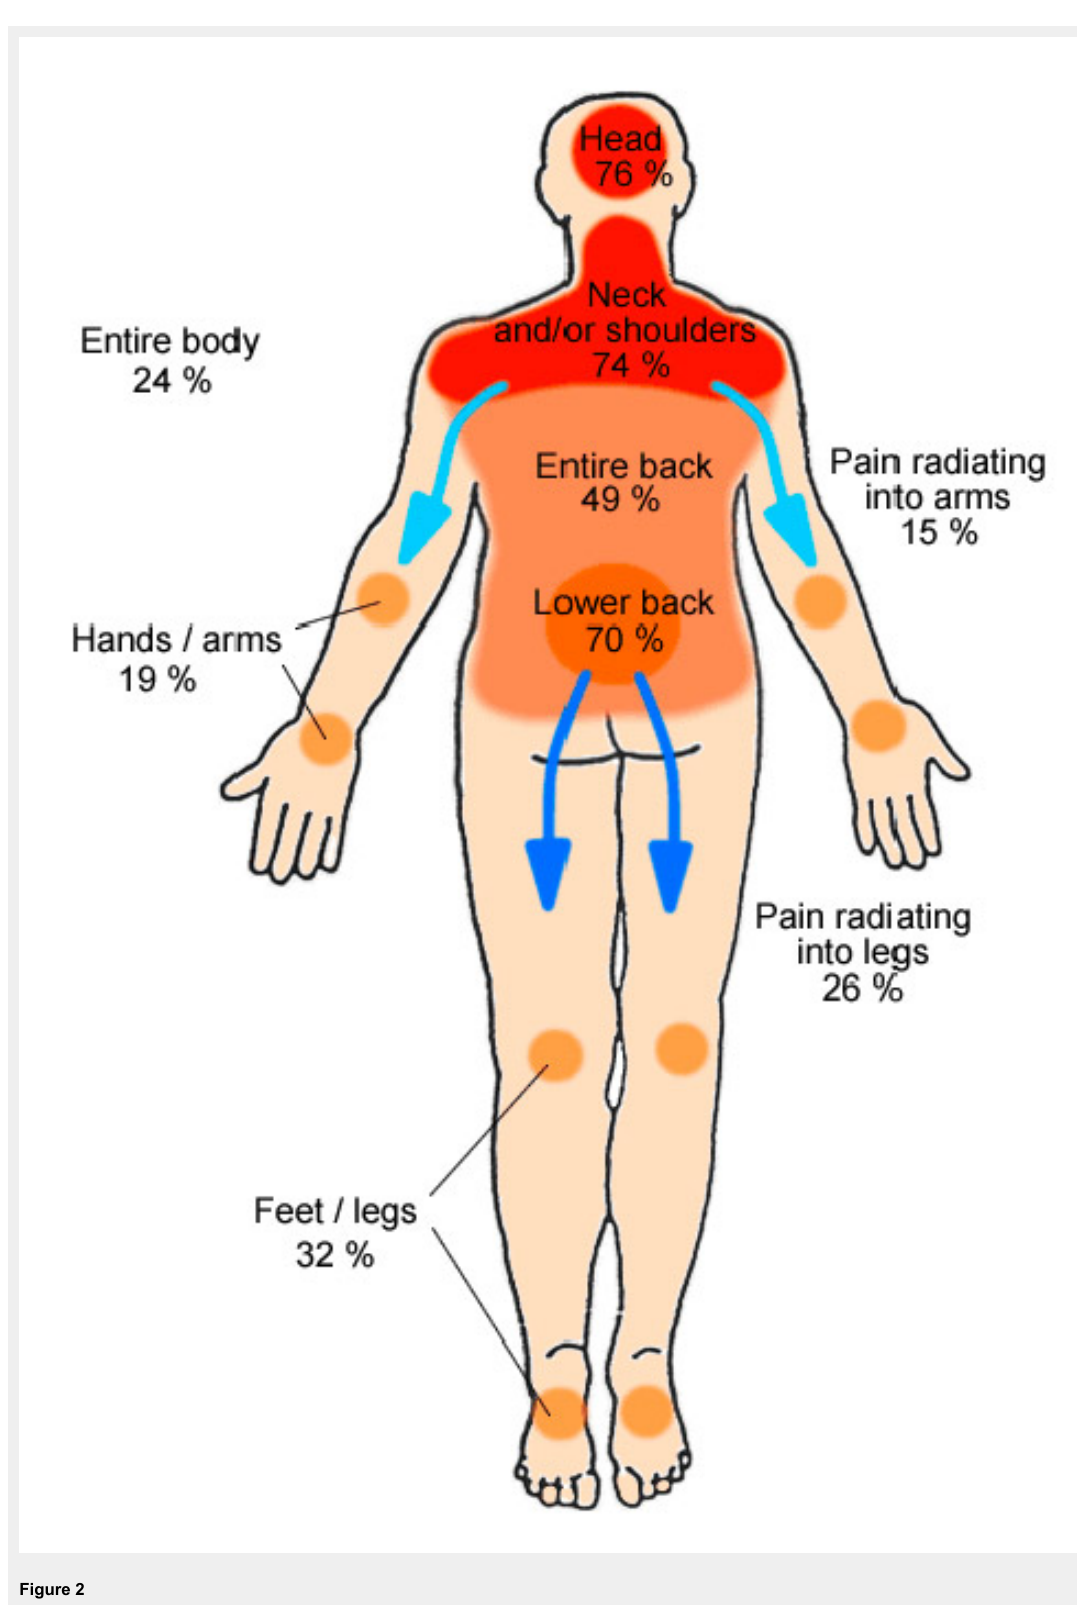
Figure 2 Graphical display of pain localisation, reported by the patients on a sketch as shown. Multiple responses were allowed (n =